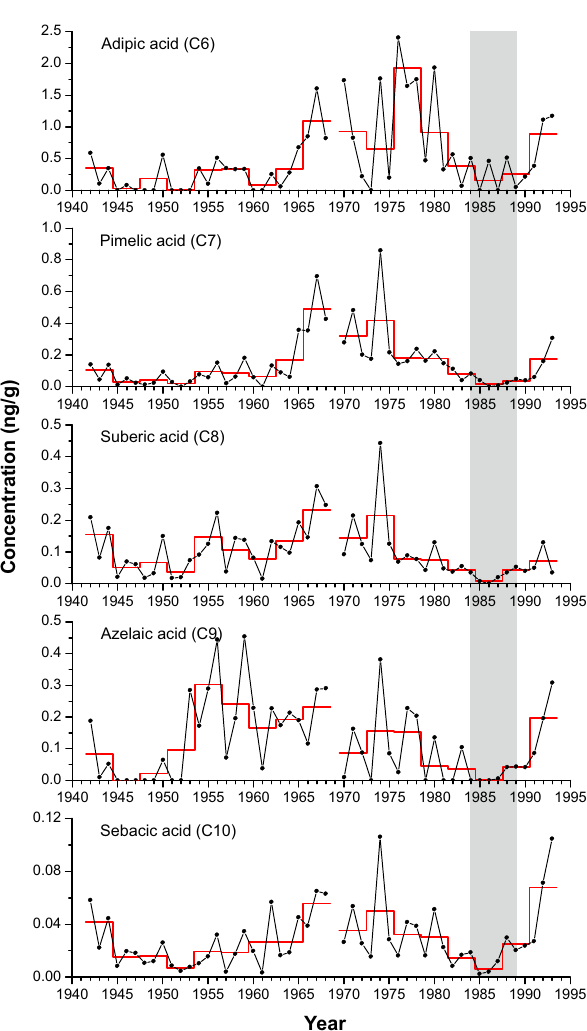
Figure 4. Ice core records of α -dicarbonyls (glyoxal and methyl- glyoxal), pinic acid, and monocarboxylic acids (vanillic and p - hydroxybenzoic acid) in the Alpine ice core from upper Grenz- gletscher (black dots: annual averages, red line: 3-year averages). The period influenced by meltwater (1984–89) is marked in